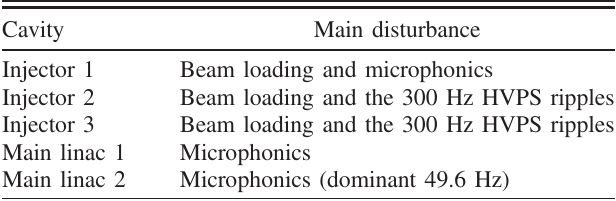
TABLE I. Main disturbances of the superconducting (SC) cavities at